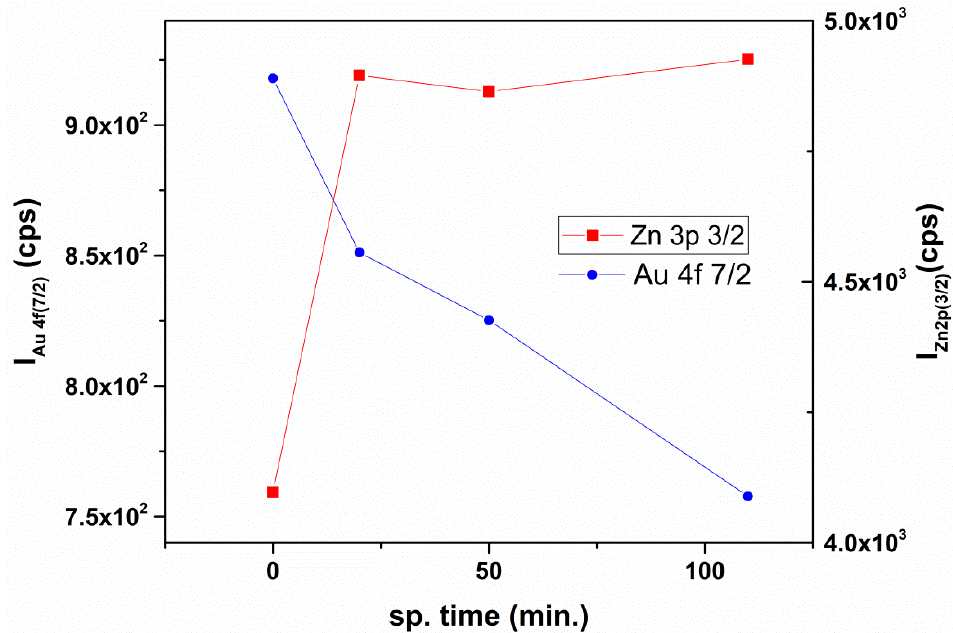
Figure 6. Comparative variation of XPS Au 4f (7/2) and Zn 2p (3/2) core–level line intensities assigned to ZnO-Au2 as a function of the etching time.